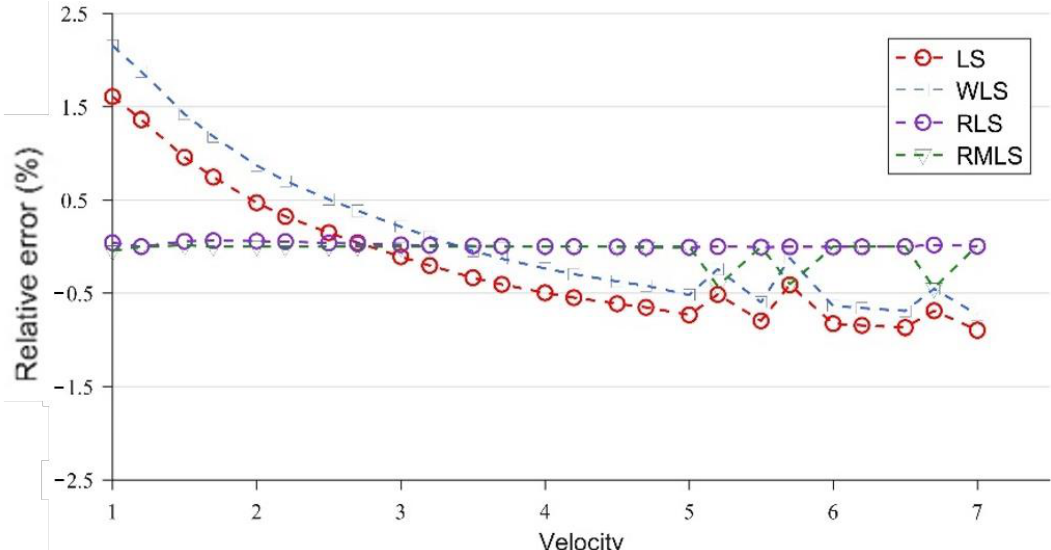
Figure 9. Results of LS, WLS, RLS, and RMLS with noise at x = 50 cm.